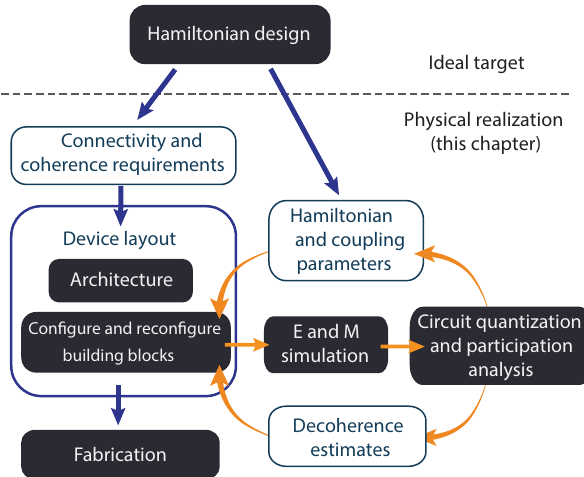
FIG. 4. Design cycle of a circuit QED device. To translate a target Hamiltonian into a physical device, we first lay out the main building blocks for the circuit in a suitable architecture. Then, we compute the electromagnetic mode structures of the device reliably, often using numerical simulations. Subsequently, we extract the relevant Hamiltonian parameters from this simula- tion using circuit quantization techniques. We then compare the result with the target Hamiltonian, and can adjust the design until we converge to a configuration that faithfully reflects our target